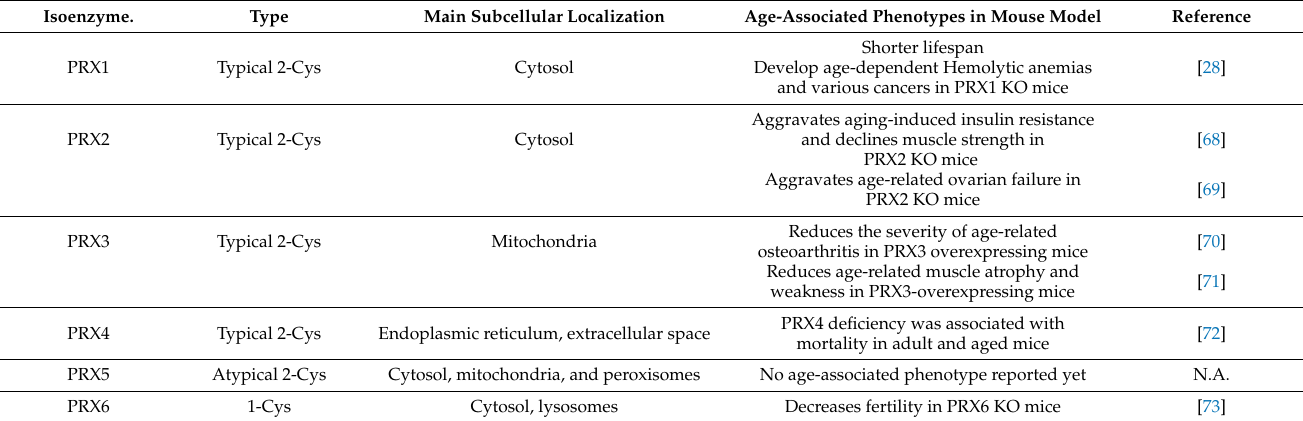
Table 1. List of mammalian peroxiredoxins and their age-associated phenotypes in mouse.